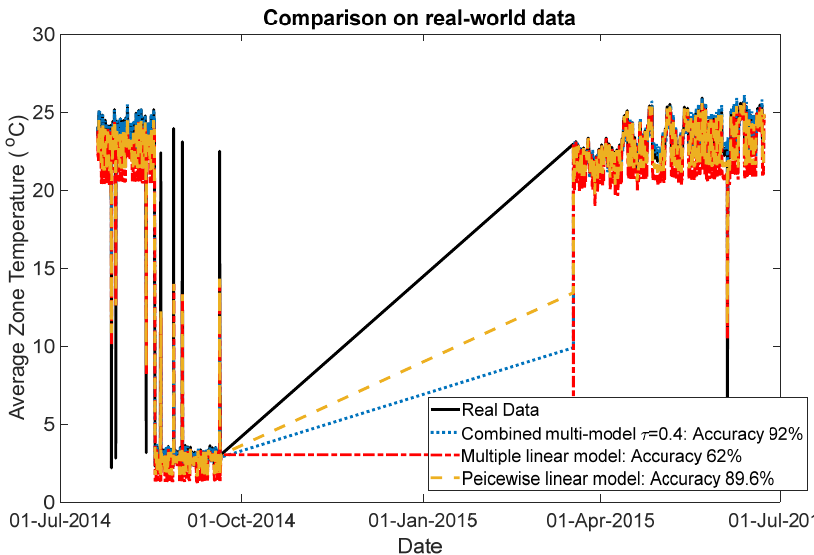
Figure 9. Performances of the three models in 500-step ahead prediction of the zone temperature.